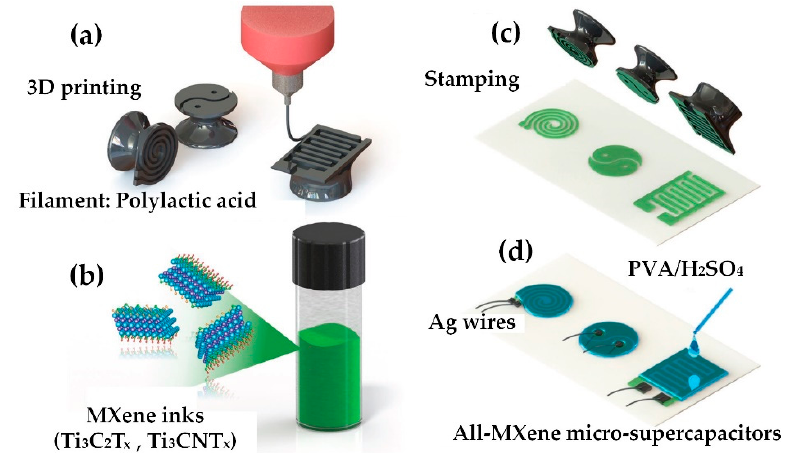
Figure 12. Fabrication of all-MXene-based MSCs using the stamping strategy. ( a ) stamps are first 3D printed, ( b ) MXene ink is controlled and prepared, ( c ) MXene ink is firmly pressed and stamped onto a rough hydrophilic substrate, and ( d ) upon attaching Ag wires and casting the electrolyte, the device is left to dry in air to form solid MXene-based MSC, reprinted with permission from [104] .